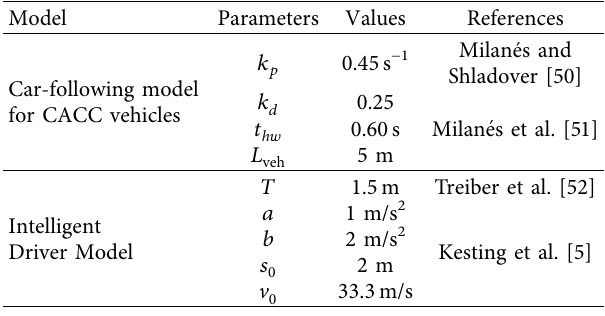
Table 2: Parameter setting for car-following models.